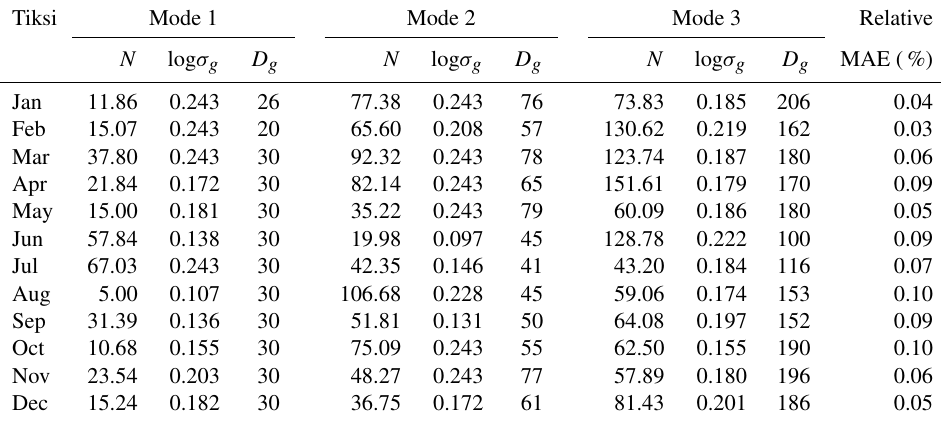
Table A4. Same as Table A1 but for Tiksi.